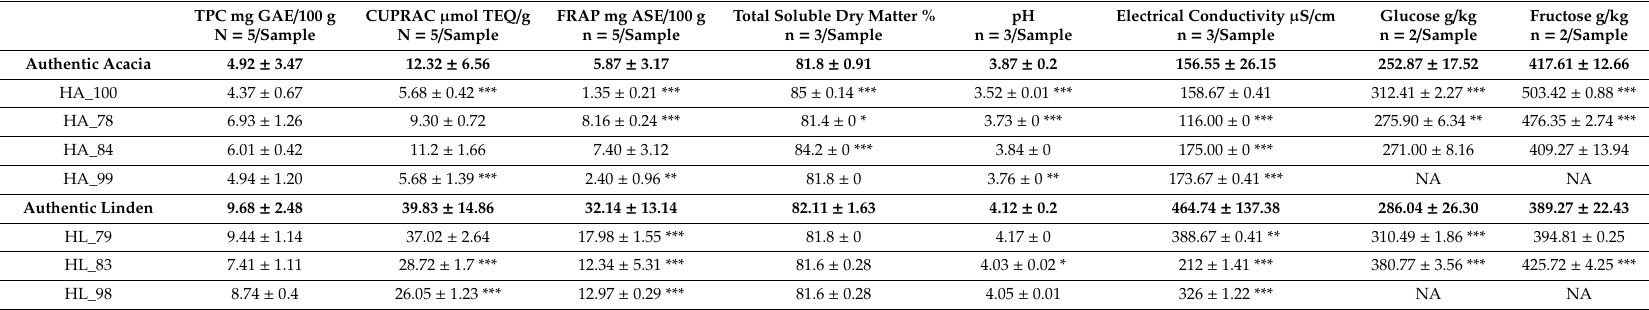
Mean ± standard deviation. The asterisk * denotes the significant di ff erences from authentic honeys based on the results of ANOVA test followed by the pairwise comparison: * p < 0.05, ** p < 0.01 and *** p <